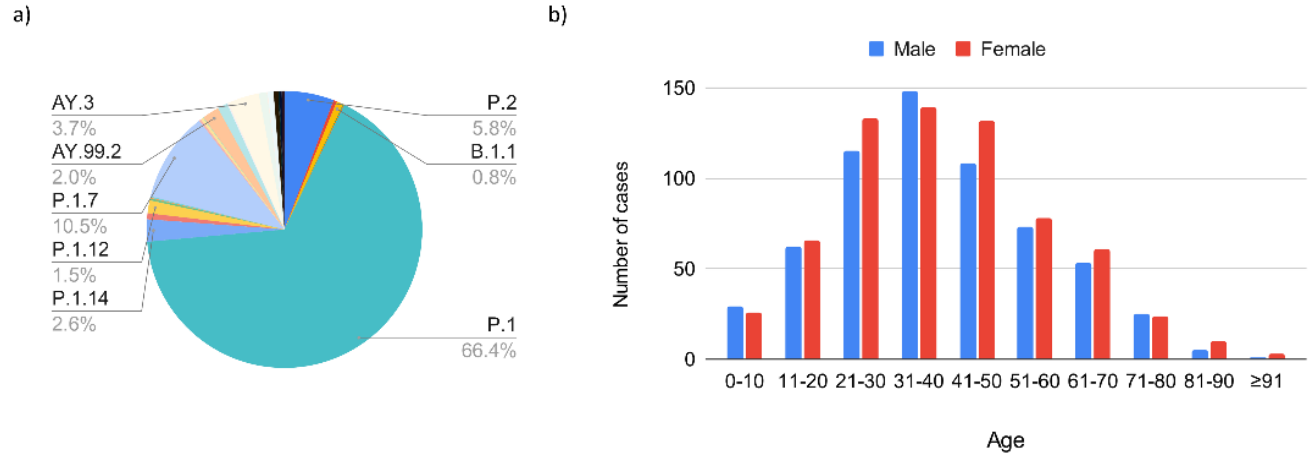
Figure 4. Surveillance of SARS-CoV-2 variants and clinical symptoms during the second wave. The data are distributed according to: ( a ) variants of interest and concern during the second wave; ( b ) demographic characteristics of the positive patients divided by sex and